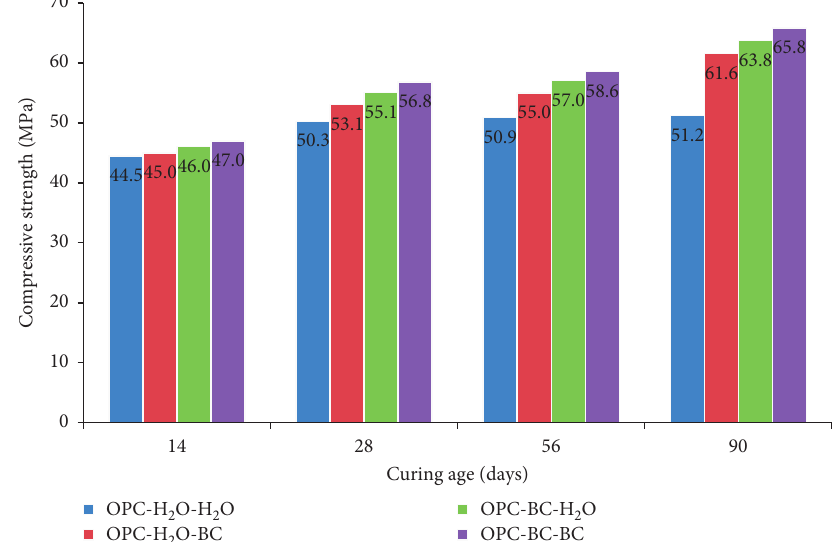
Figure 1: Test results for compressive strength for varied curing period.